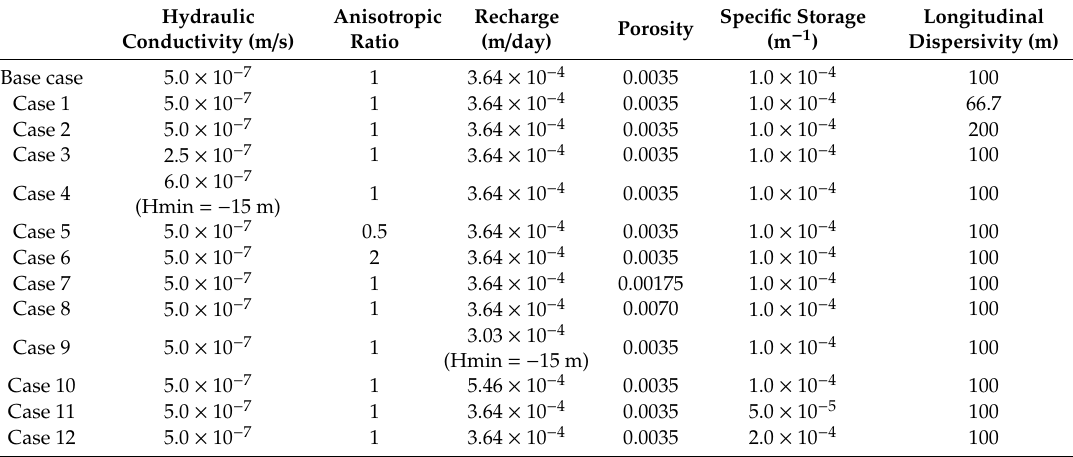
Table 1. Parameters that were used for the homogeneous